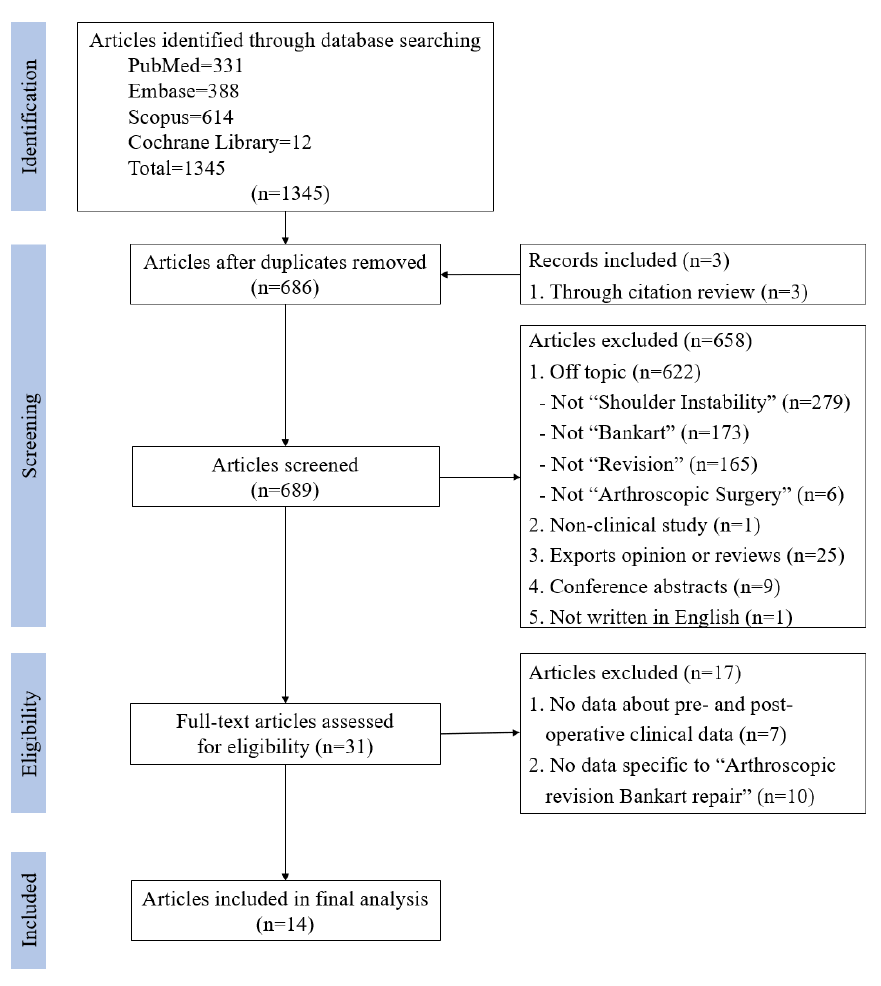
Figure 1. PRISMA (preferred reporting items for systematic meta-analyses) flow diagram.